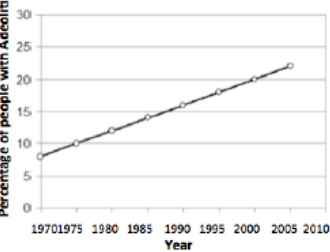
Figure A2. Numeracy and graph literacy items.